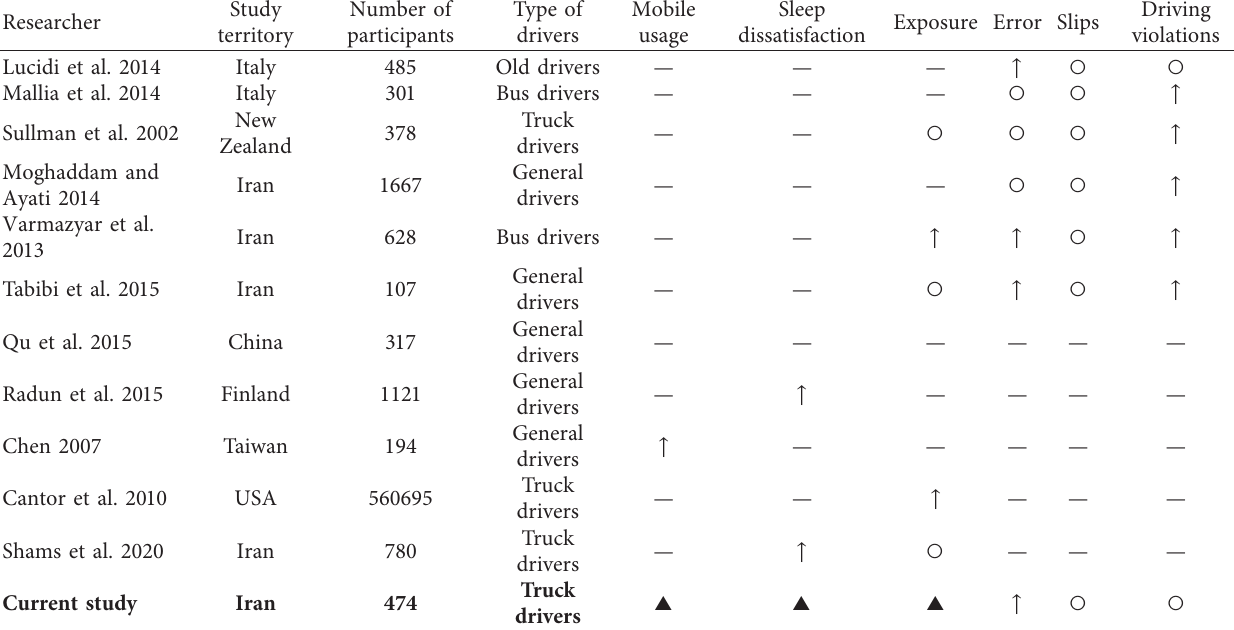
Table 7: Comparison of the SEM result with previous researches [6–8, 10–12, 15, 21, 23, 41,